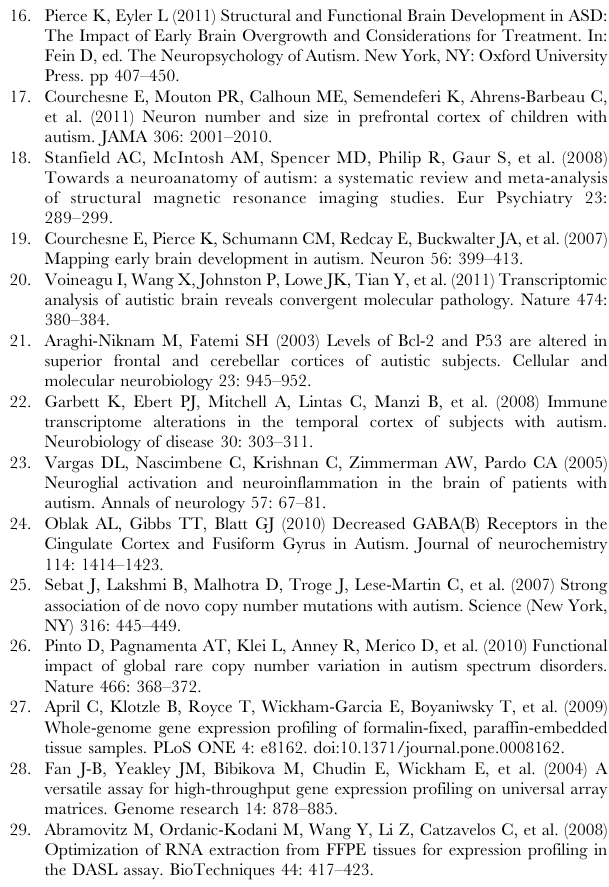
diagnosis passing a threshold of p , 0.05 between autism and control cases, Illumina probe IDs, p-value of difference, cytoge- netic bands and fold changes are listed. Table S6 Significant dysregulated pathways of autistic cases across all young and older ages (2 to 56 years). Dysregulated pathways enriched in genes showing a main effect of diagnosis (p , 0.05; FDR , 0.1) identified using the MetaCore software suite between autism and control cases, p-value and network objects are listed. Pathways are sorted by pathway category name. (PDF) Table S7 Chromosomal locations of CNV regions found in all autistic cases (males and females). Chromosomal location, number (N) of SNPs, size of the SNP in base pairs (bp) and annotated gene content of CNV regions found in all autistic cases (males and females) are listed. Overlapping regions with the same gene content but different breakpoints are listed as distinct CNVs. Enrichment results are presented in Figure 4. Table S8 Chromosomal locations of CNV regions found in all control cases (males and females). Chromosomal location, number (N) of SNPs, size of the SNP in base pairs (bp) and annotated gene content of CNV regions found in all control cases (males and females) are listed. Overlapping regions with the same gene content but different breakpoints are listed as distinct CNVs. Enrichment results are presented in Figure 4.